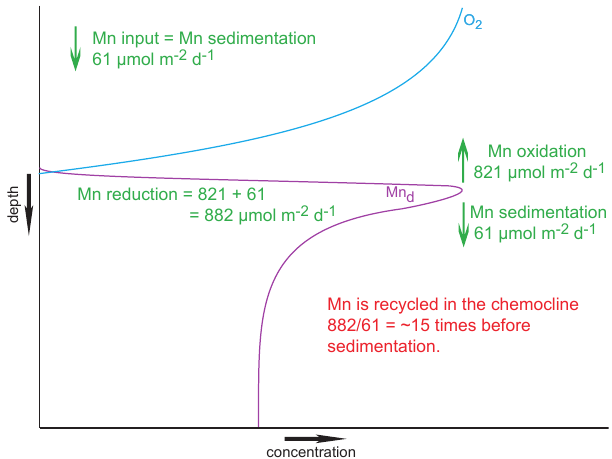
Fig. 10. Calculated fluxes and recycling rates of Mn in Lake